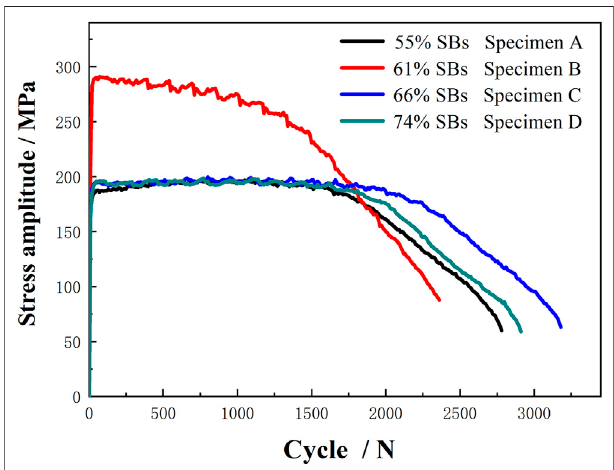
FIGURE 6 | The cyclic stress response curves of the initial specimen (specimen A) and the GBE-treated specimens (specimen B to specimen D).